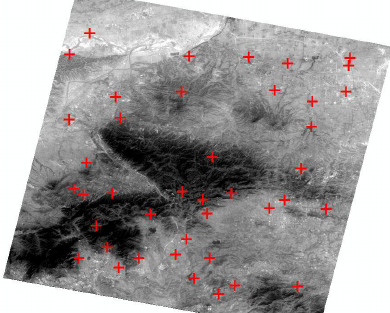
Figure 1. The distribution of the points measured by GPS (Liu et al., 2016)